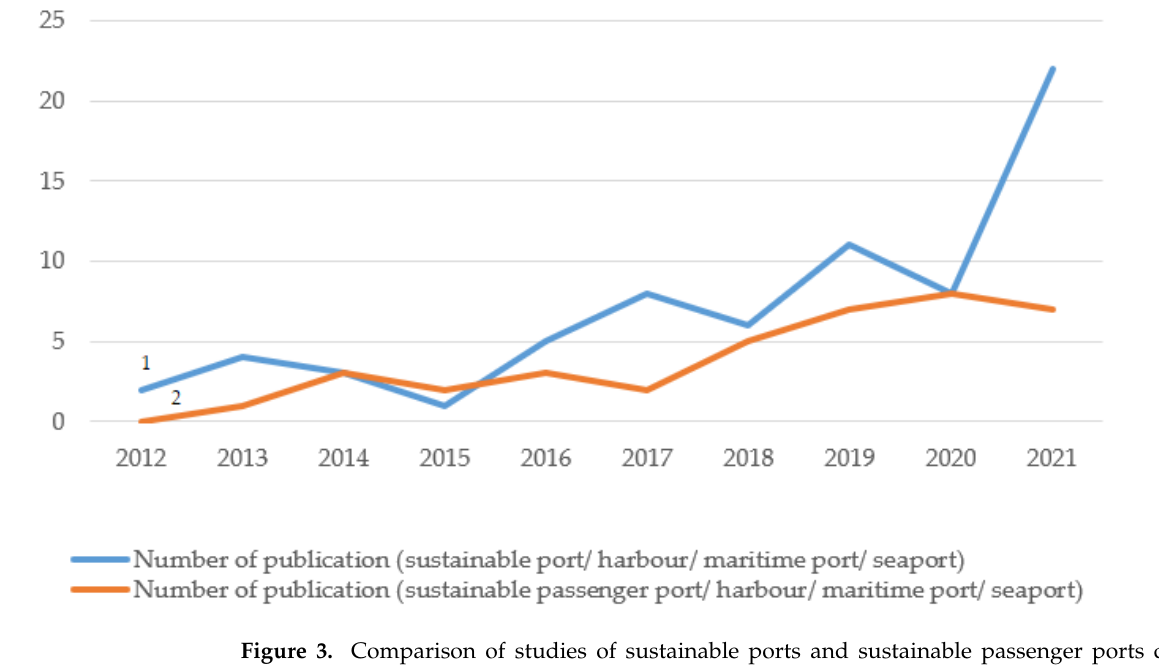
Figure 3. Comparison of studies of sustainable ports and sustainable passenger ports during 2012 – 2021, found on Web of Science on 15 March, using Topic search: (1) (TS = ( “ sustainable port * ” or “ sustainable maritime port * ” or “ sustainable harbour * ” or “ sustainable seaport * ” ); (2) TS = ( “ sustainable passenger port * ” or “ sustainable passenger maritime port * ” or “ sustainable passenger harbour * ” or “ sustainable passenger seaport * ” ).